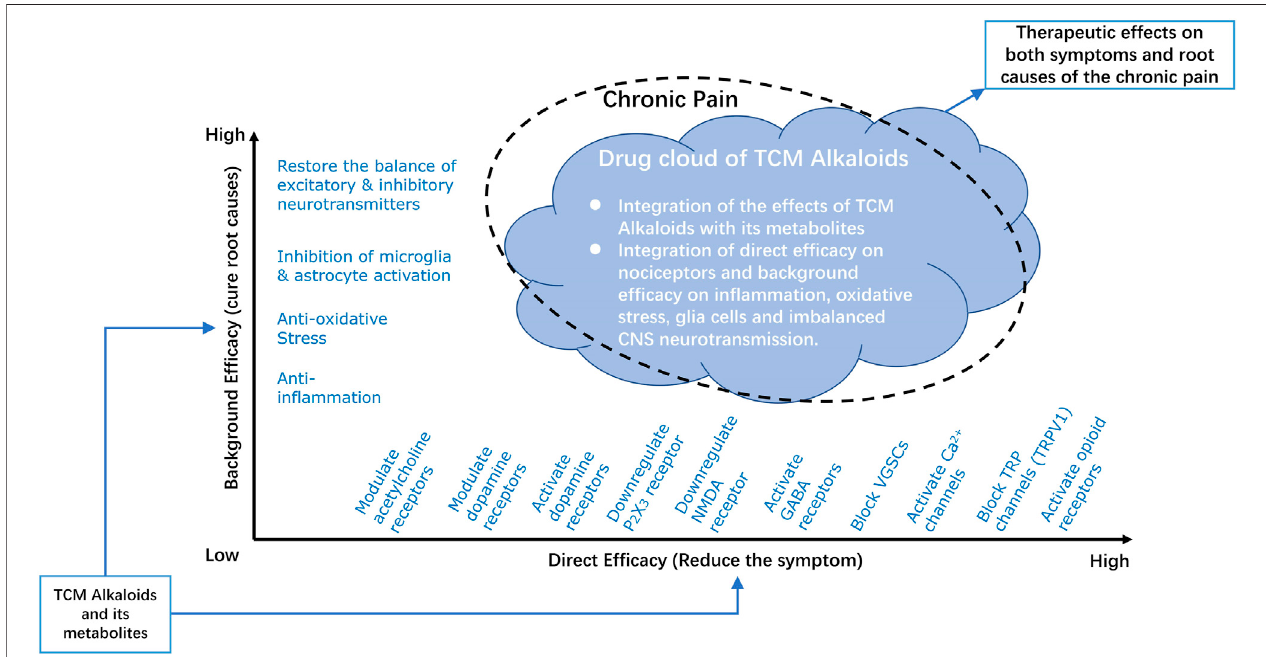
FIGURE2| DrugCloudofTCMderivedAnalgesicAlkaloids.TheintegratedanalgesicpropertiesofTCMderivedalkaloidsareillustratedbyintroducingthenotionof drug cloud. The drug cloud could be described from two dimensions, which are direct ef fi cacy and background ef fi cacy. Direct ef fi cacy refers to direct actions of TCM derived alkaloids on nociceptors or pain relaying network through activation/inhibition of ion channels or regulation the expression of certain receptors, such as by downregulating P2X3 or NMDA receptors, activating dopamine, GABA, or opioid receptors, and blocking VGSCs, Ca 2+ , or TRP channels. Background ef fi cacy refers to the ability of TCM derived alkaloids to reverse the root causes of the chronic pain disease, including inhibition of in fl ammation and oxidative stress, inhibition of microgliaandastrocyteactivitiesandrestorethebalancebetweenexcitatoryandinhibitoryneurotransmitters.ThechemicalbasisofdrugcloudisTCMderivedalkaloids togetherwithitsmetabolites. Byintegration ofthedirectef fi cacyandbackgroundef fi cacy,thischemicalbasisofTCMderivedalkaloidscouldhaveprofoundtherapeutic effects on both symptoms and root causes of chronic pain. NMDA, N-methyl- D -aspartate; GABA, γ -amino butyric acid; VGSCs, voltage-gated sodium channels; TRP, transient receptor potential; TRPV1, transient receptor potential vanilloid receptor